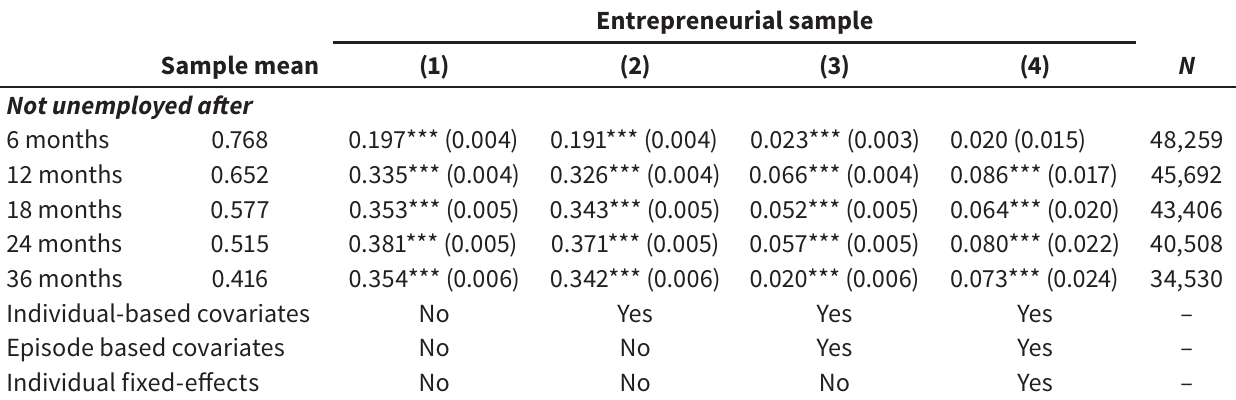
Results, unemployment reentry: linear